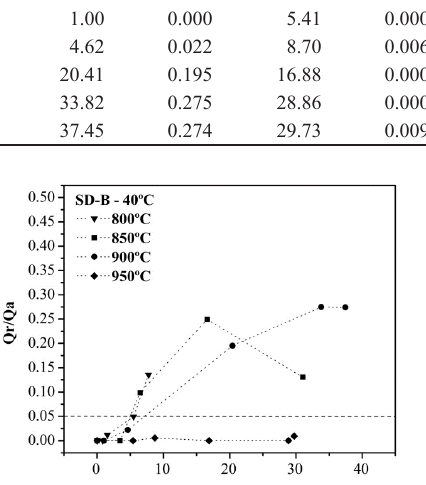
SO Figure 8. Q /Q versus deleterious phases for SD-B in 2.00 M H 2 4 r a + 0.01 M KSCN + 0.50 M NaCl solution test at 40 °C.